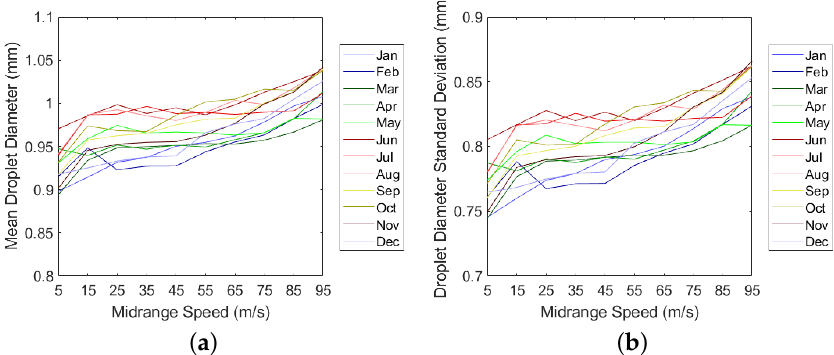
Figure 15. The variation of mean ( a ) and standard deviation ( b ) for droplet diameter with the midrange tip speed of each bin for each month, as calculated by the